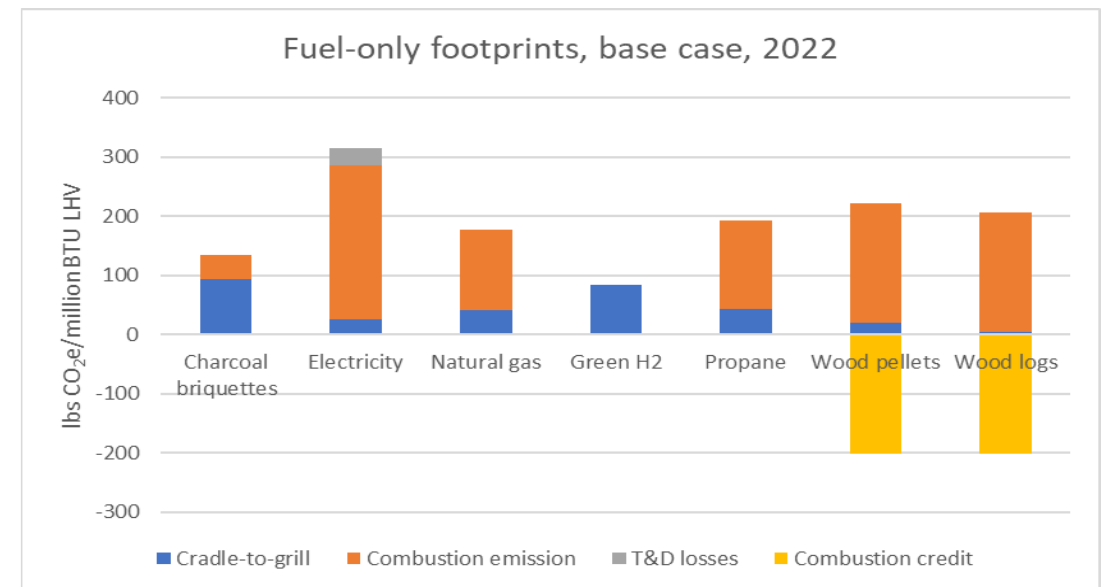
Figure 2. Carbon footprints for grills, grill-specific and fuel-only, USA 2022.